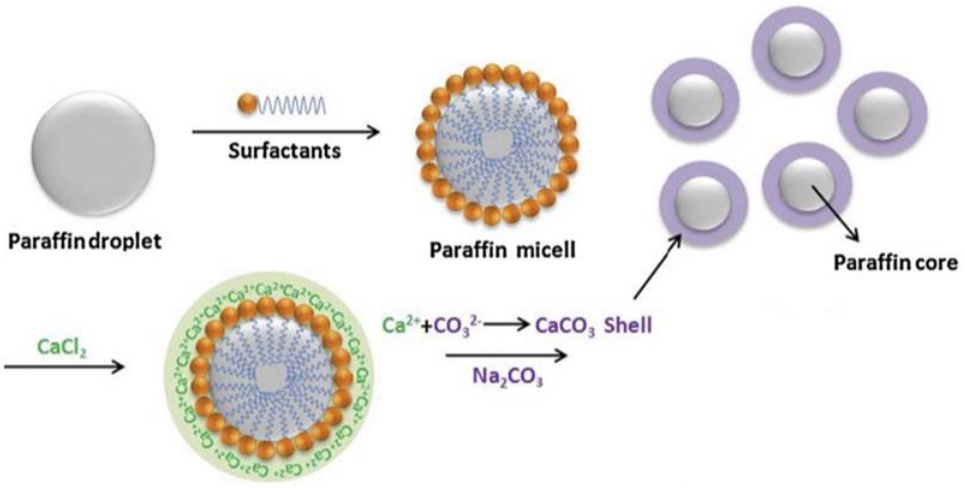
Figure 9. Schematic of paraffin micro-encapsulation in CaCO 3 shell [78].